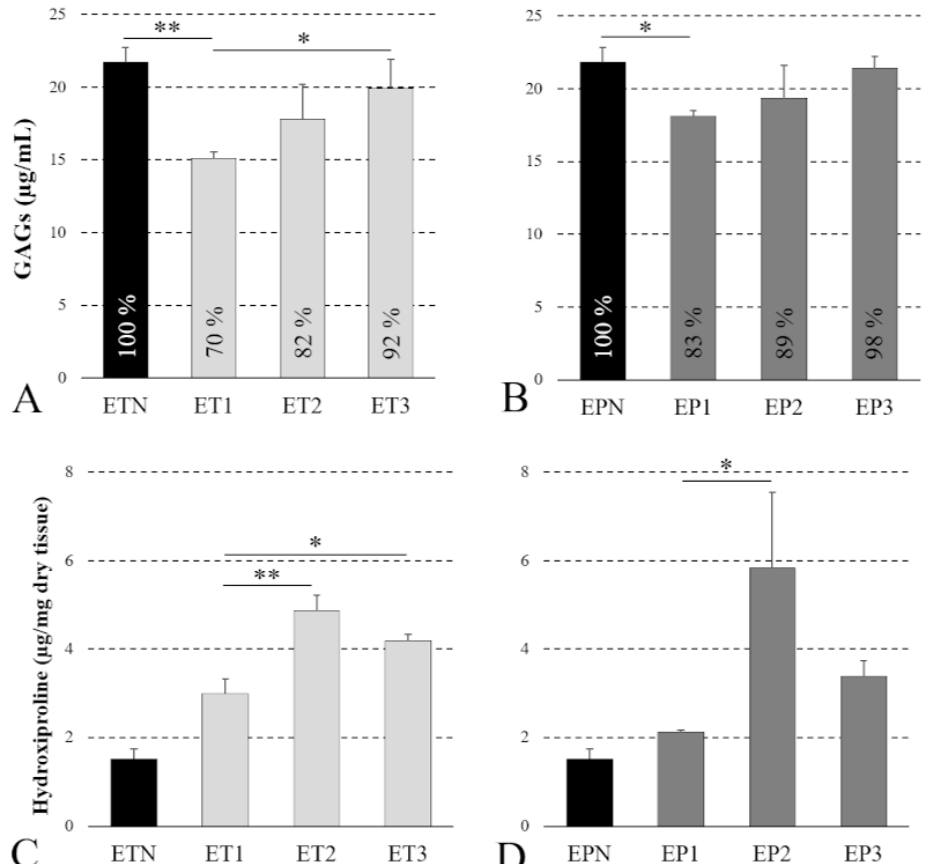
Figure 4. GAG and collagen preservation. Quantification of residual GAGs ( A , B ) and hydroxyproline ( C , D ) into esophageal tubules (ETs) and patches (EPs) before (ETN, EPN) and after decellularization with Protocols Nos. 1 (ET1, EP1), 2 (ET2, EP2) and 3 (ET3, EP3) (* p < 0.05; ** p <